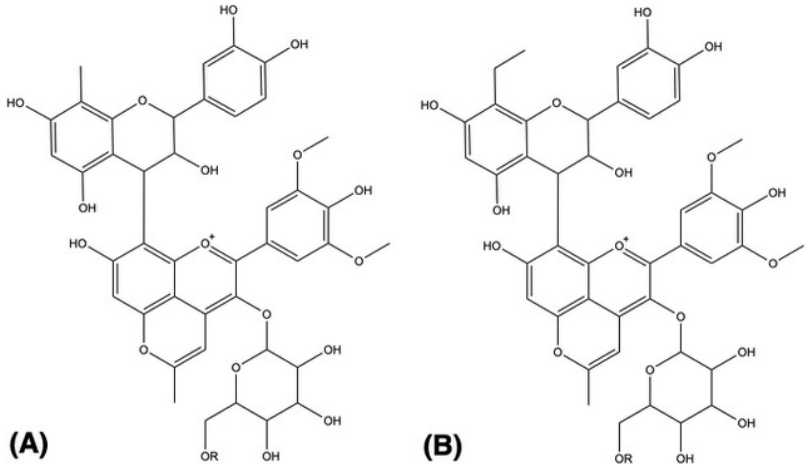
Figure 2. Proposed structure for the ( A ) methyl-catechin-methylpyranoanthocyanins (compounds 37 , 38 ) and ( B ) ethyl-catechin-methylpyranoanthocyanin pigments (compounds 39 – 41 ). R = H, acetyl or coumaroyl group.